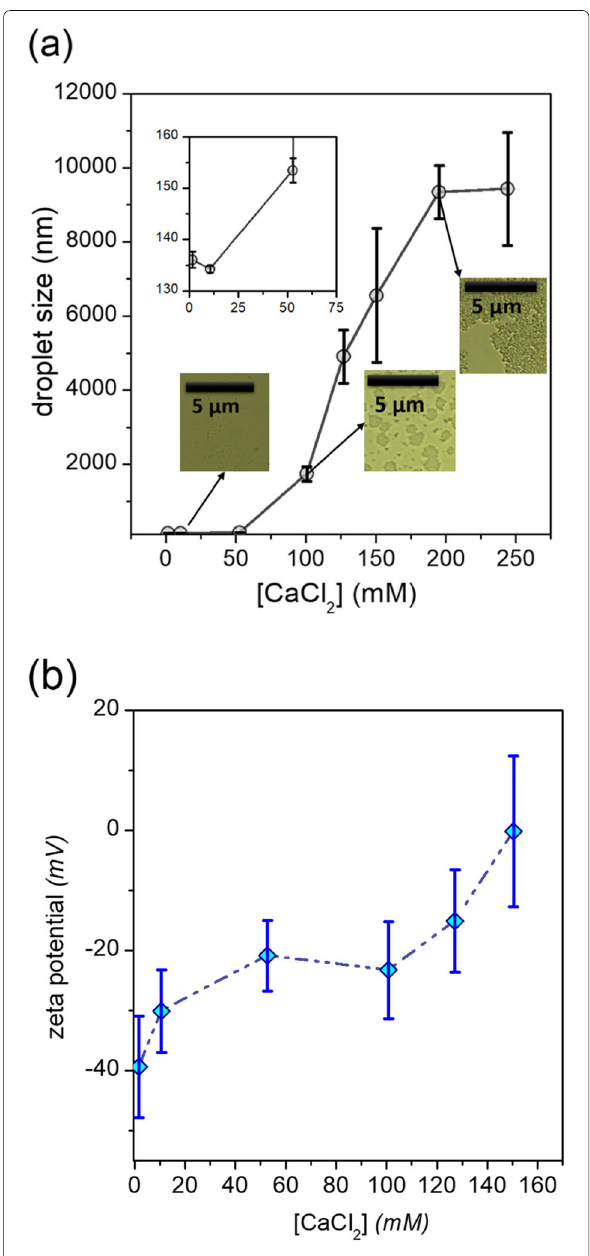
Fig. 9 a Variation of d z of the optimized CD CBD nanoemulsion as a function of increasing calcium chloride concentration; (inset) optical micrographs of the optimized nanoemulsion in the presence of varying concentrations of CaCl 2 ; b Variation of ζ potential of